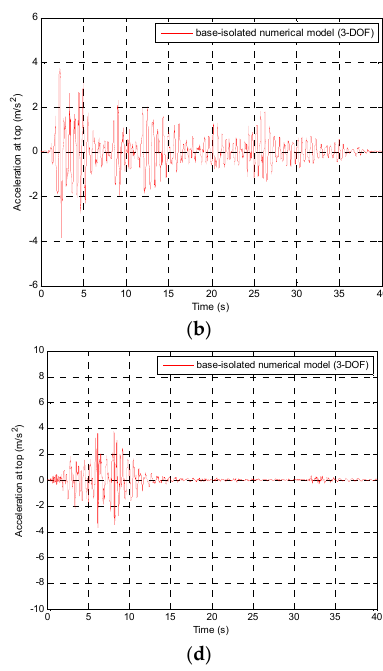
Figure 7. Experimentally determined ( left ) and numerically obtained ( right ) time-acceleration history plots for the fixed-base two-storey model during different ground motions: the 1940 El Centro earthquake ( a , b ), the 1971 San Fernando earthquake ( c , d ), the 1989 Loma Prieta earthquake ( e , f ), the 1994 Northridge earthquake ( g , h ), and the 2002 Polkowice mining tremor ( i , j ).